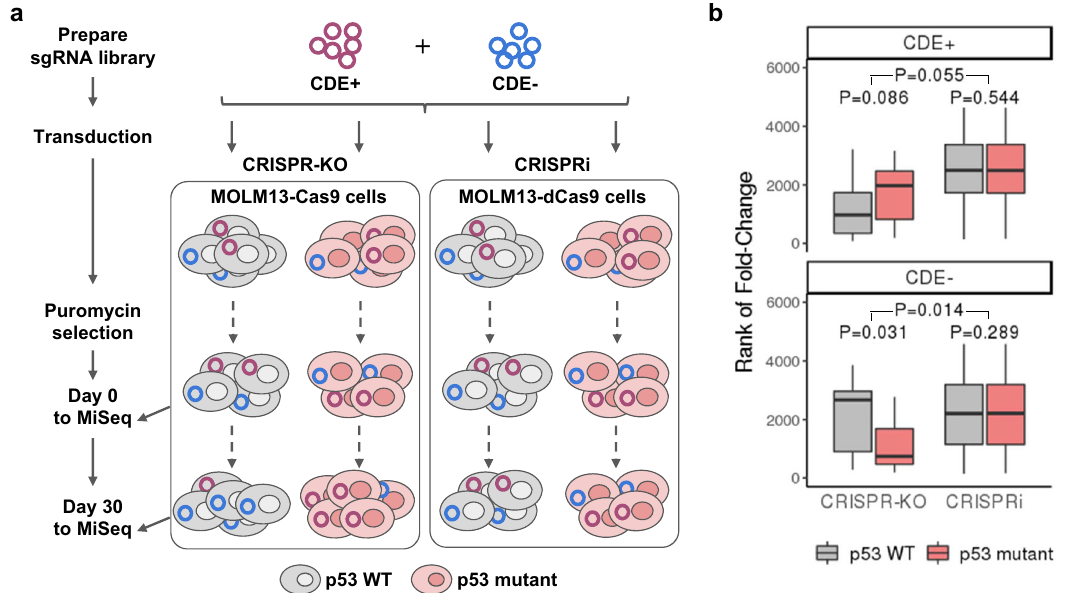
Fig. 2 Validation of p53 CDE genes in isogenic MOLM13 cell lines via pooled CRISPR screens. a A fl owchart showing the experimental procedure of CRISPR-KO and CRISPRi screening of pooled p53 CDE + / − genes in a pair of p53 -isogenic MOLM13 cell lines (see the “ Methods ” section for details). b The day 30 to day 0 fold-change (converted to rank) of reads corresponding to the sgRNAs for p53 CDE + genes (upper panel) and CDE − genes (lower panel), in p53 WT MOLM13 cells (gray boxes) vs. the isogenic p53 -mutant cells (red boxes) for the CRISPR-KO and CRISPRi screenings, respectively. 10 guides per gene were designed for the top 200 of each CDE + and CDE − genes and were used to derive statistics here. The bottom P values are for two-sided Wilcoxon signed-rank tests comparing p53 WT and mutant cells, the upper ones are P values of non-parametric tests comparing the difference of p53 mutant and WT rank values between CRISPR-KO and CRISPRi experiments. In the boxplots, the center line, box edges, and whiskers denote the median, interquartile range, and the rest of the distribution in respective order, except for points that were determined to be outliers using a method that is a function of the interquartile range, as in standard box (Supplementary Fig. 3, screens quality control discussed in Supplementary Note 9 and Supplementary Fig. 4). This fi nding is further con fi rmed by mining seven CRISPR-KO genome-wide screens 21 , including two p53 -null and fi ve p53 -WT RPE1 cells screens (Supplementary Fig. 5, Supplementary Note 3).